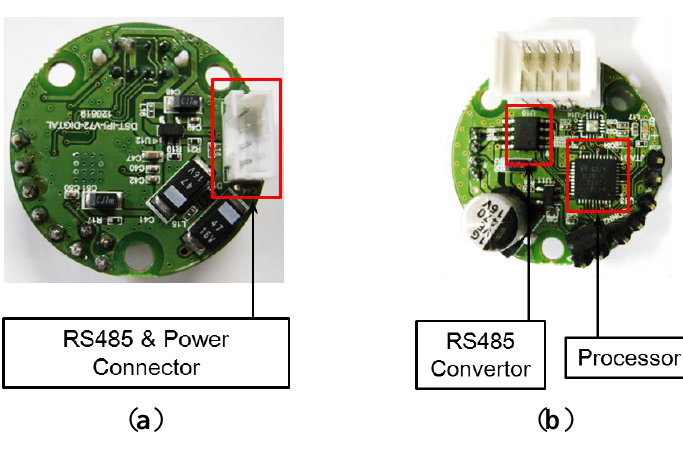
Figure 6. Processor module. ( a ) Front side; ( b ) Back